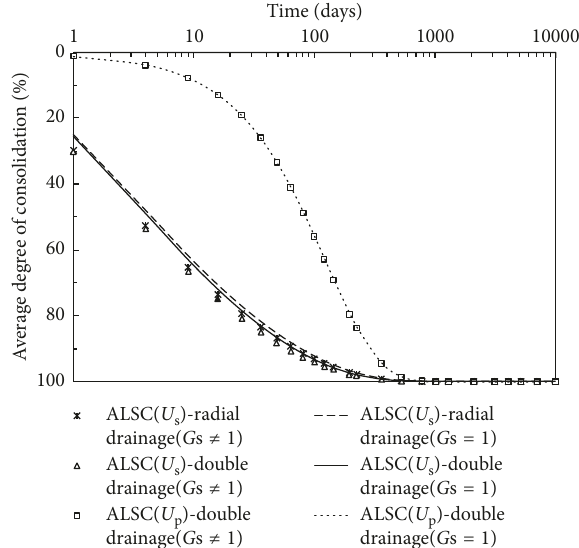
Figure 6: Effect of self-weight on the degree of consolidation of double drainage and radial flows only.